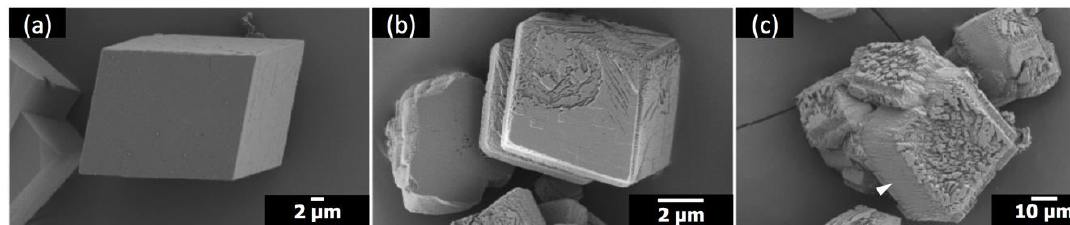
( c ) 5 µ M PAA without Sr(II); ( c ) 5 μM PAA without Sr(II) .